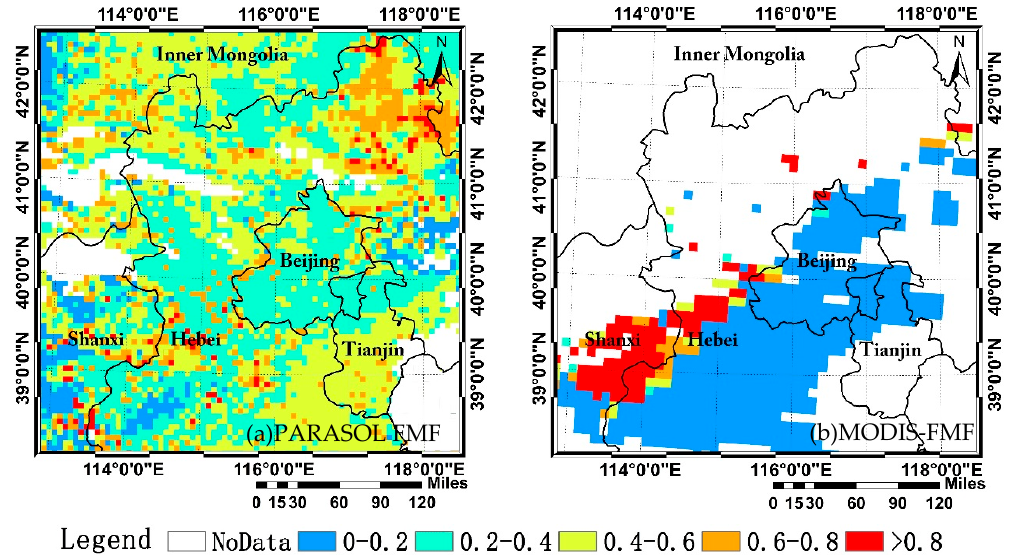
Figure 5. The comparison of the FMF retrieval results of PARASOL and MODIS FMF products for 28 April 2012. ( a ) is the FMF result of this work; and ( b ) is the FMF result of MODIS. MODIS refers to Moderate-resolution Imaging Spectroradiometer.